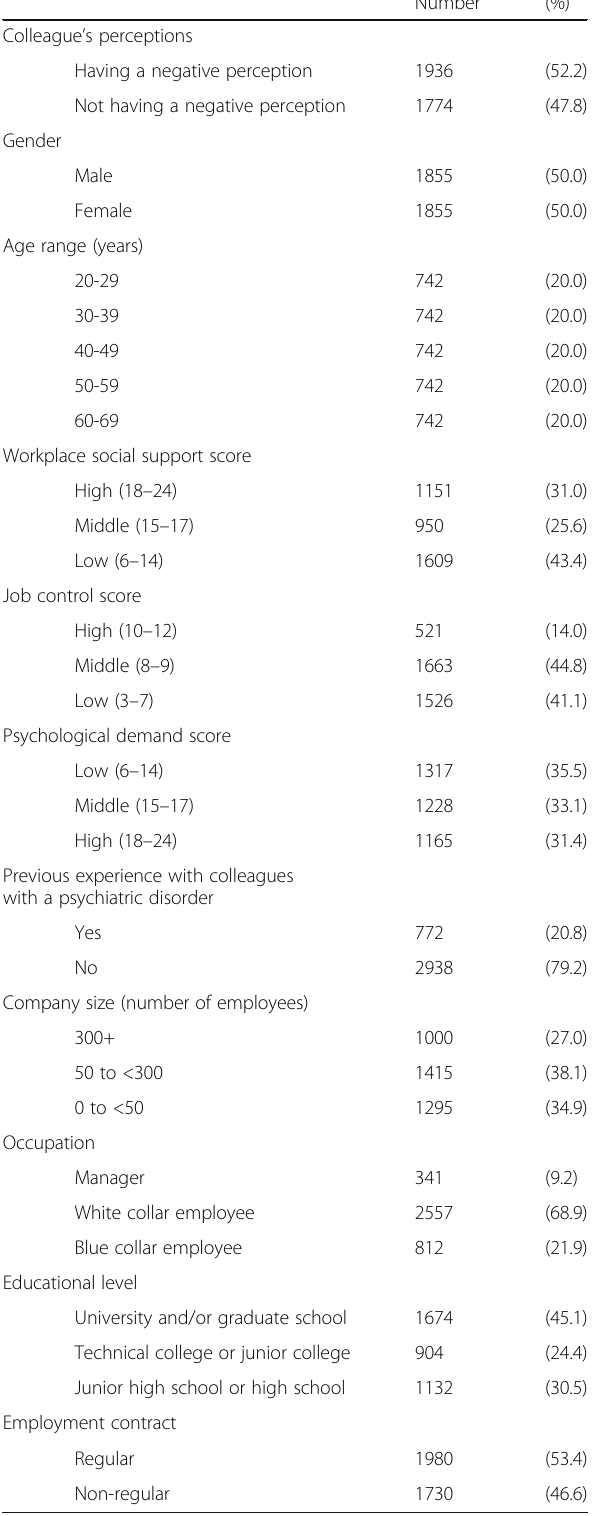
Table 1 Participant characteristics ( n =